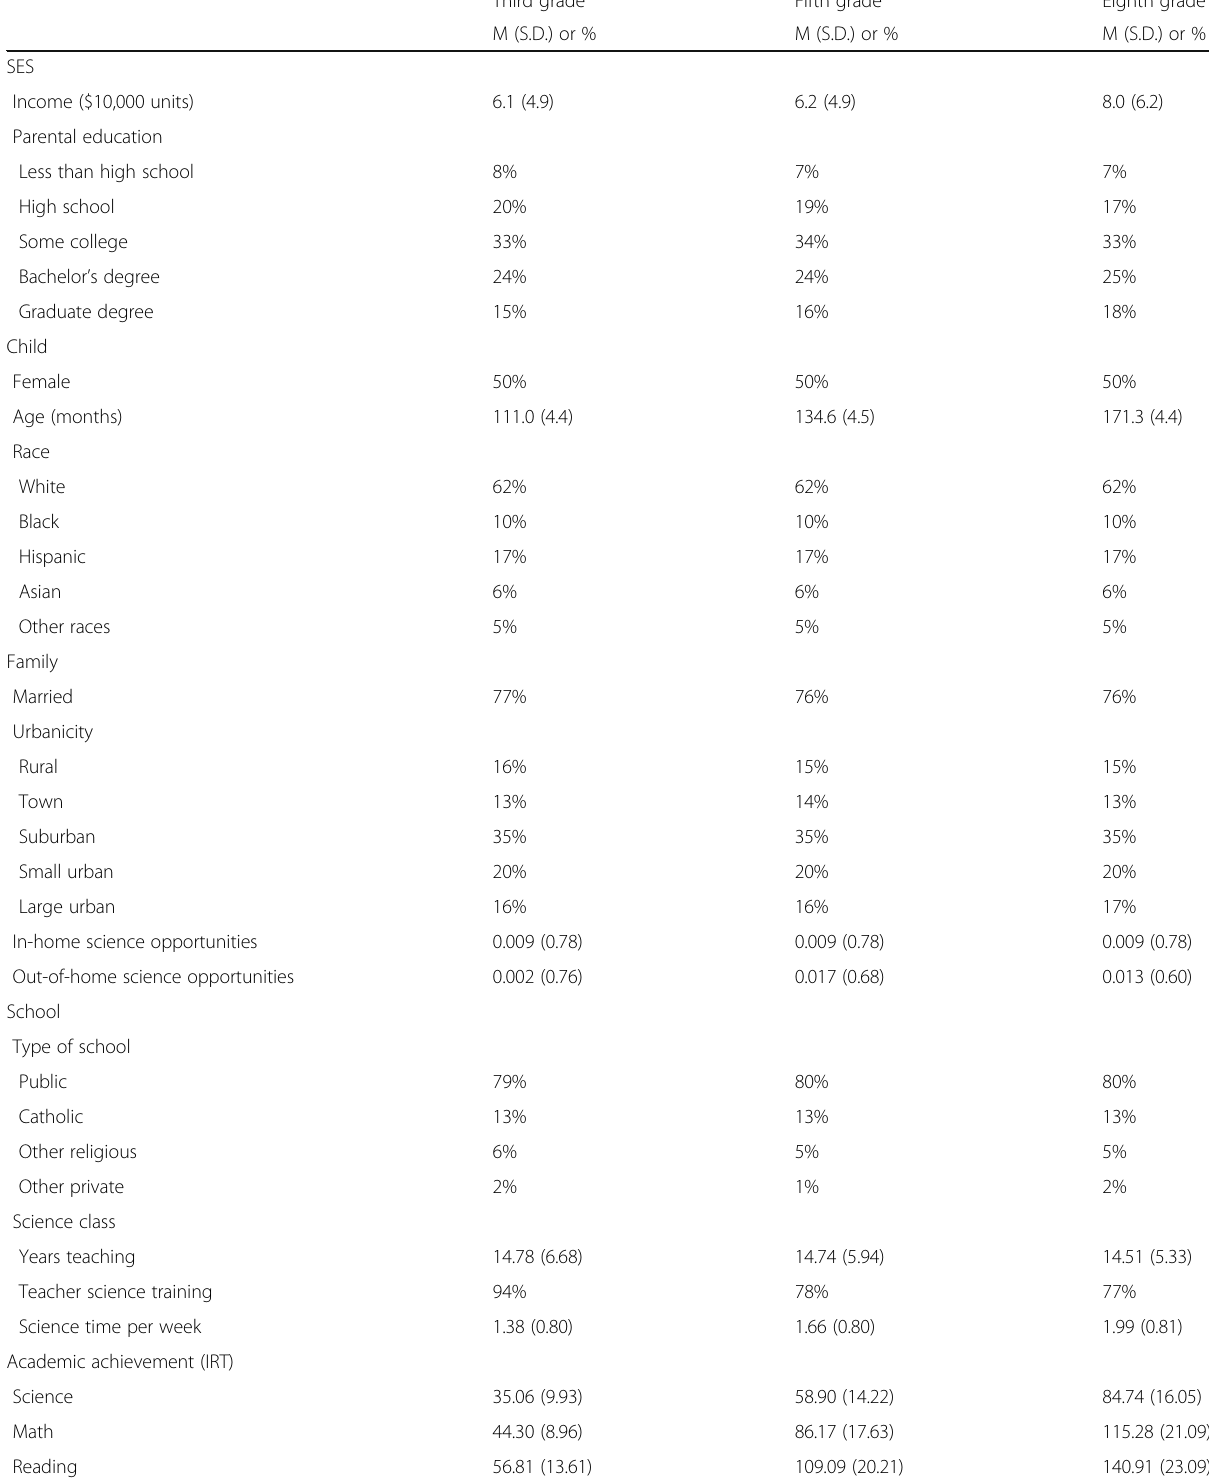
Table 1 Descriptive statistics for all